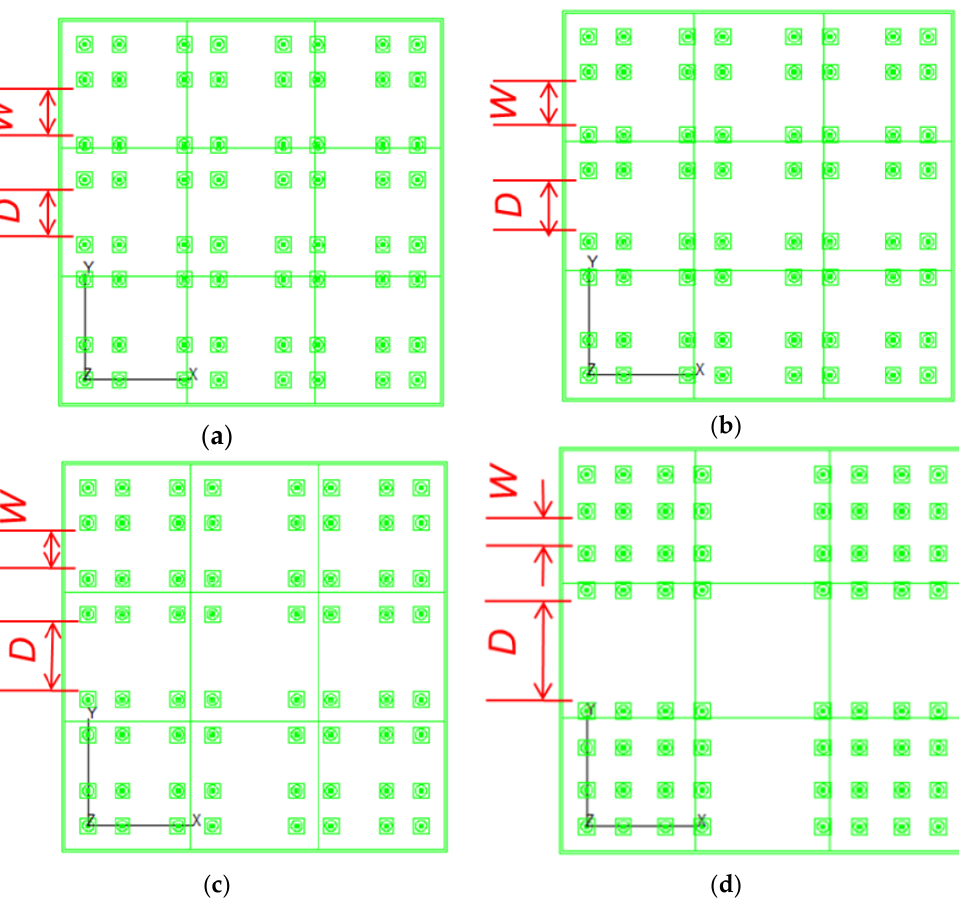
Figure 11. LED arrangement of each type: ( a ) Type (a), ( b ) Type (b), ( c ) Type (c), ( d ) Type (d).